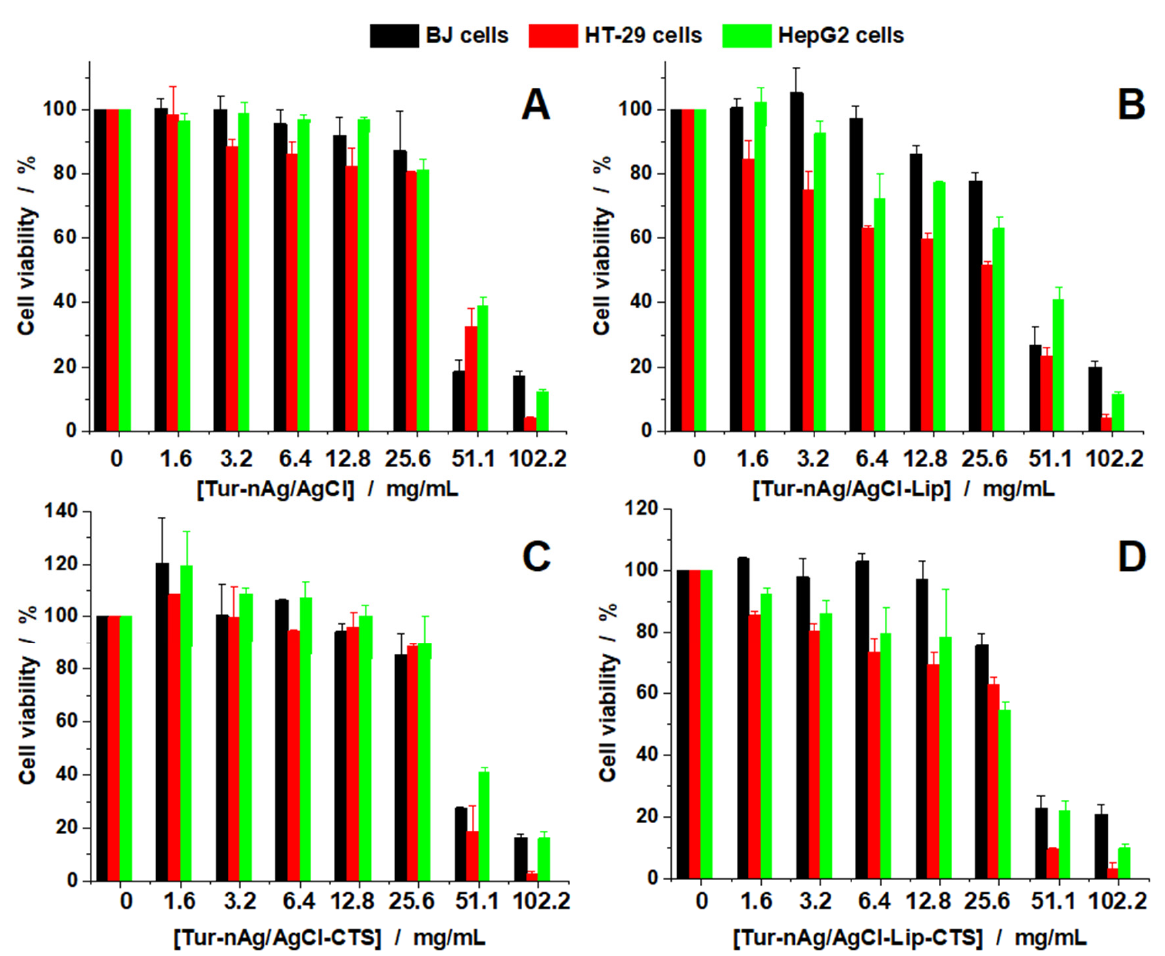
Figure 10. Cell viability of BJ, HT-29, and HepG2 cell lines treated with different concentrations of the samples investigated: Tur-nAg/AgCl ( A ), Tur-nAg/AgCl-Lip ( B ), Tur-nAg/AgCl-CTS ( C ) and Tur-nAg/AgCl-Lip-CTS ( D ). Table 2. Half inhibitory concentration (IC 50 ) and therapeutic index (TI) for the compounds.